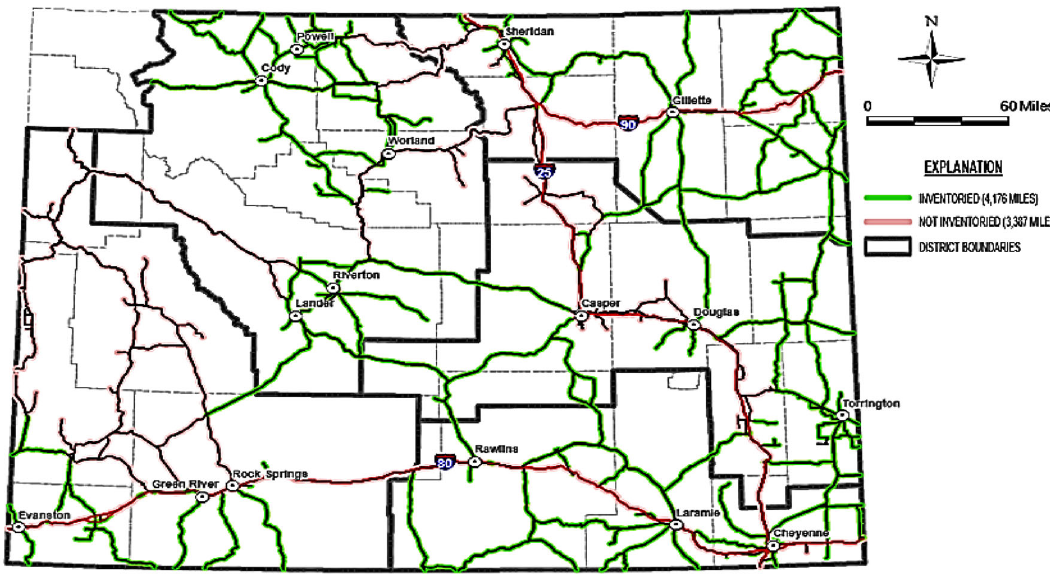
Fig. 1 Roads with traffic barrier inventoried in this